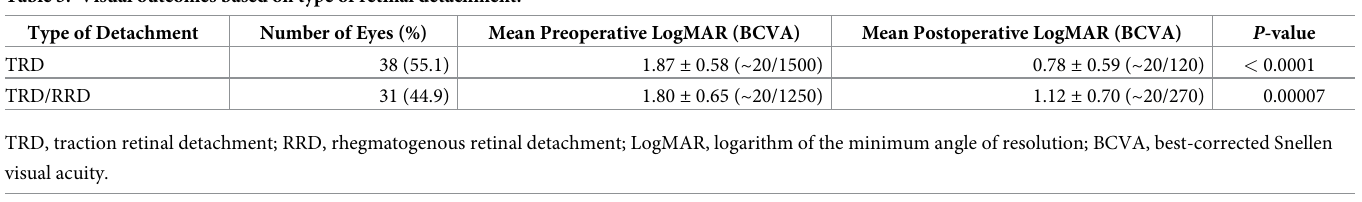
Table 5. Visual outcomes based on type of retinal detachment.